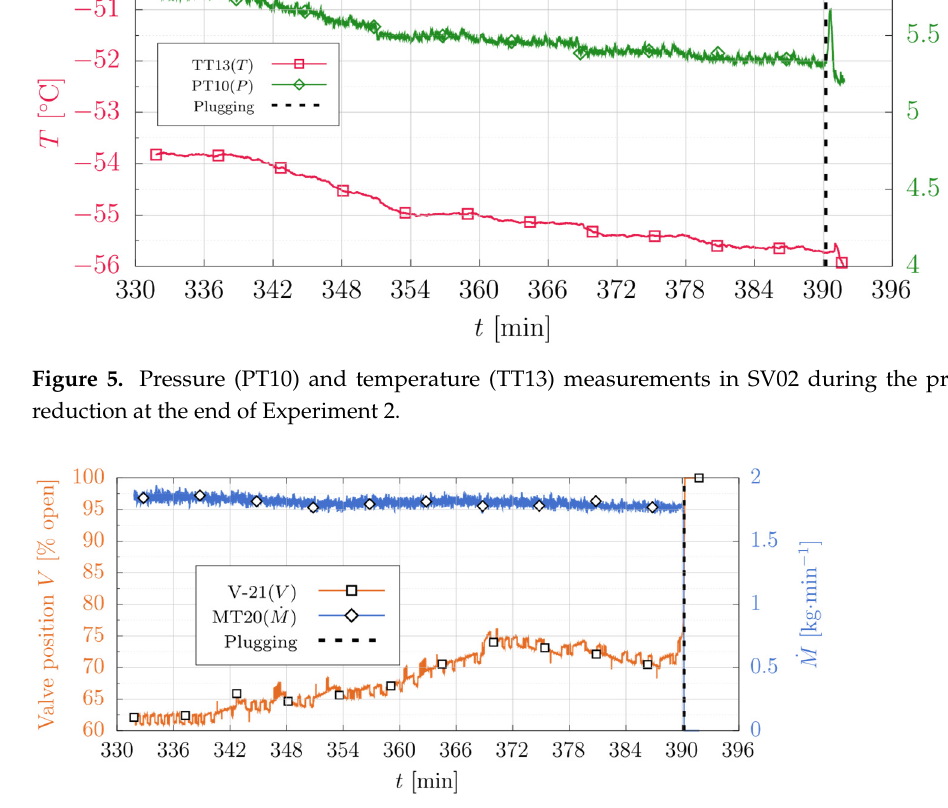
Figure 6. Mass follow rate (MT20) and valve position V-21 during the reduction of pressure at the end of Experiment 2. At the time of the plugging the mass flow rate of MT20 goes to zero and the valve V-21 opens fully to 100%.